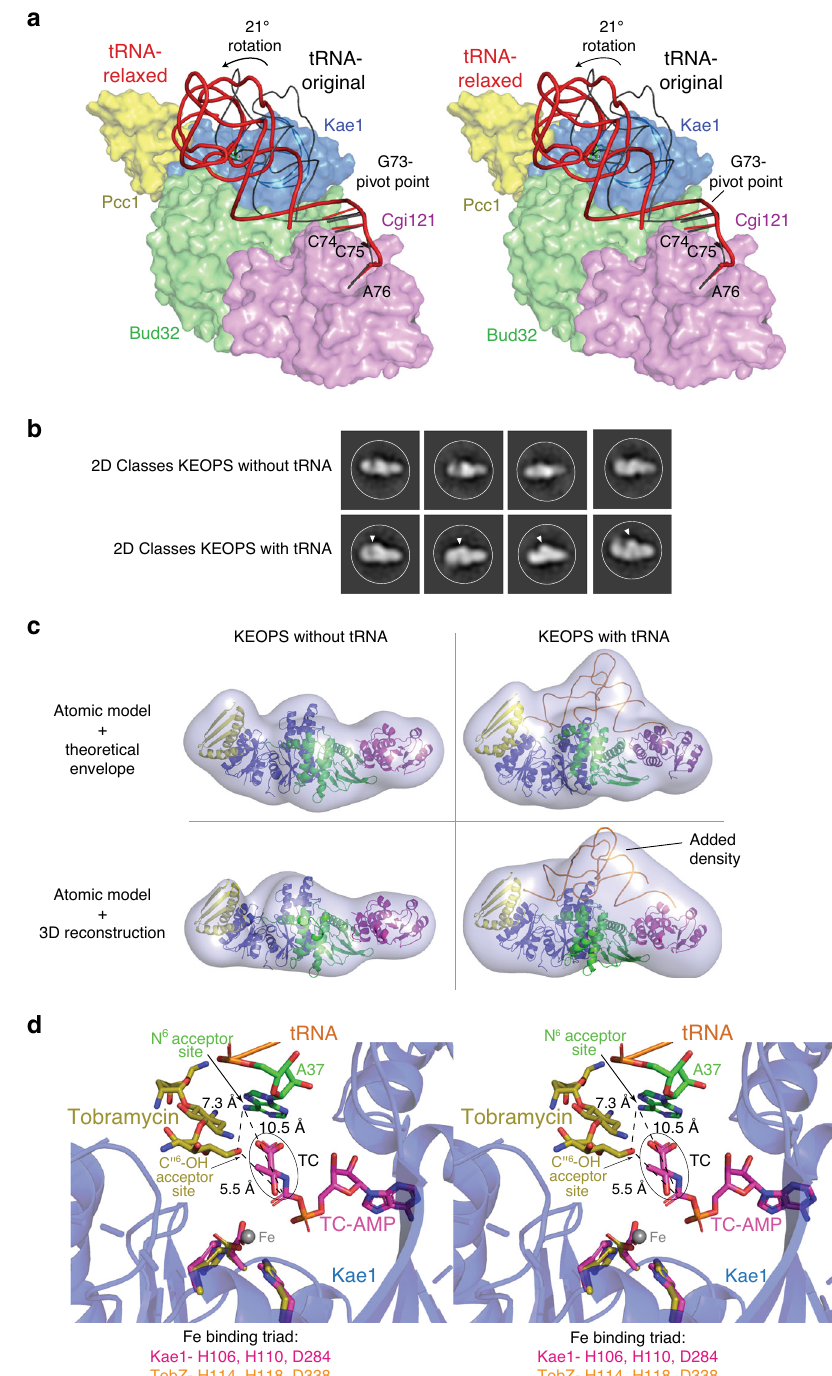
Fig. 4 Composite model of the ar KEOPS holo-enzyme bound to tRNA is suggestive of an enzyme – substrate complex. a Stereo surface representation of ar KEOPS bound to mj tRNA Lys (see methods for model construction). Black ribbon represents the position of tRNA prior to energy minimization. Note the severe steric clash between tRNA and the Kae1 subunit. Red ribbon represents the position of tRNA following energy minimization (see Methods). The steric clash between tRNA and Kae1 is relieved by a 21° rigid body pivot of tRNA centered at the junction between tRNA nucleotides G73 and C74. For clarity, only the positions of the last four bases of the tRNA are shown. b Representative two-dimensional class averages of KEOPS with and without tRNA determined by single particle negative stain electron microscopy. Additional density observed in the tRNA-bound specimen is indicated by the white triangles. c Three-dimensional reconstructions of KEOPS with and without tRNA derived from the two-dimensional-classes. (Top) atomic models and their superimposed theoretical envelopes of KEOPS alone (left) and KEOPS bound to tRNA (right). (Bottom) atomic models fi tted into the 3D reconstructions of KEOPS alone (left) and KEOPS bound to tRNA (right). d Zoom-in stereo view of the active site region of mj Kae1 with the KEOPS – tRNA model (blue) highlighting the distance between the modeled position of the A37 modi fi cation acceptor site and the modi fi cation acceptor site of tobramycin as well as the predicted distances to the position of the donor atom of TC-AMP. The TobZ-tobramycin enzyme – substrate complex (PDB 3VET) was superimposed on the Kae1 subunit in the composite model shown in ( a ) by alignment of metal binding residues using